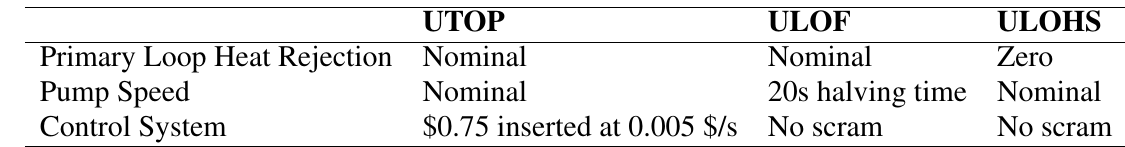
Table 1: Assumptions specific to each of the three transients